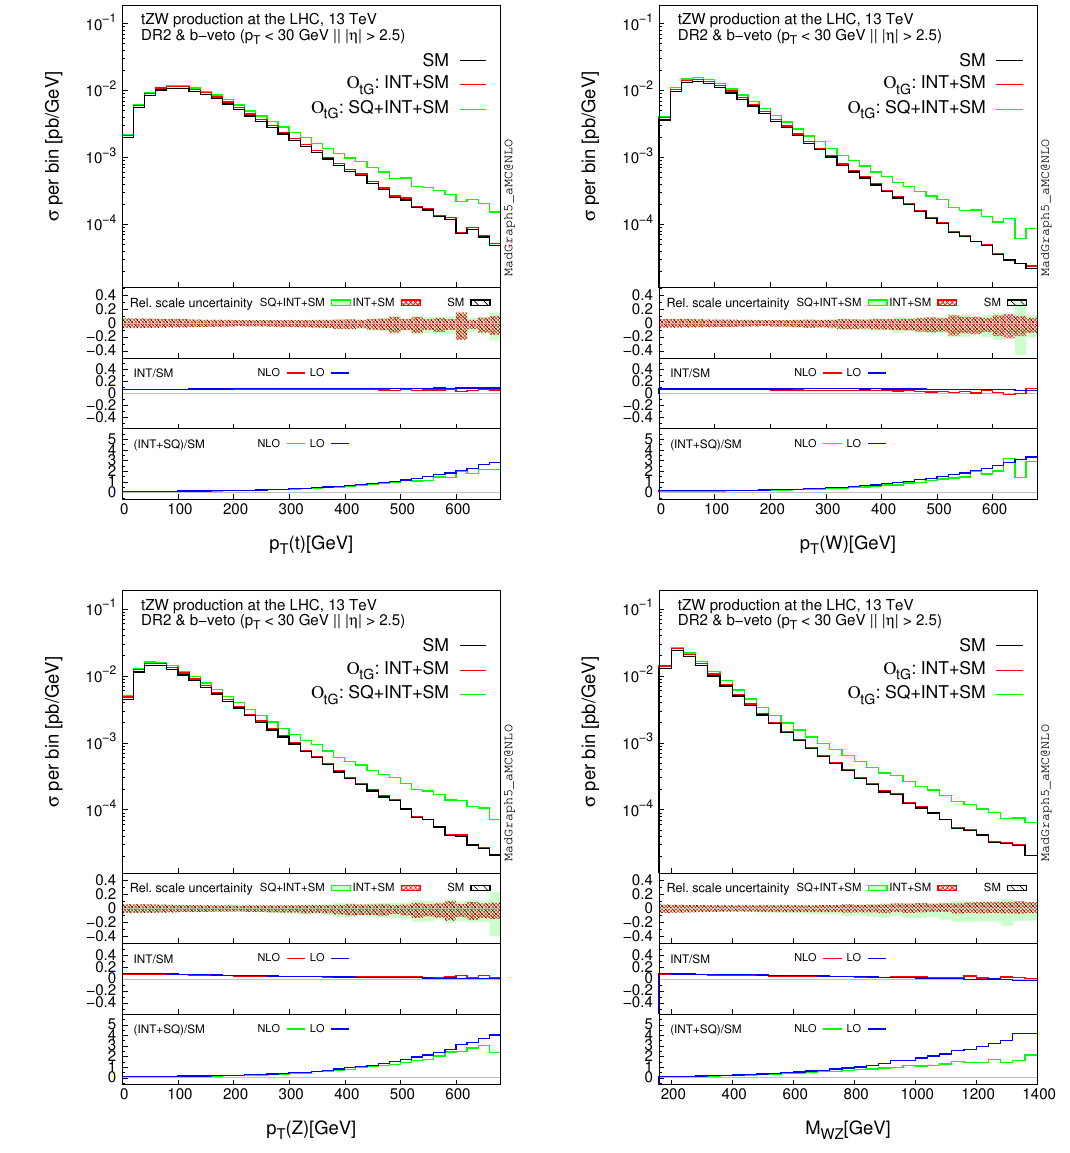
Figure 12 . Same as figure 9 but for the O